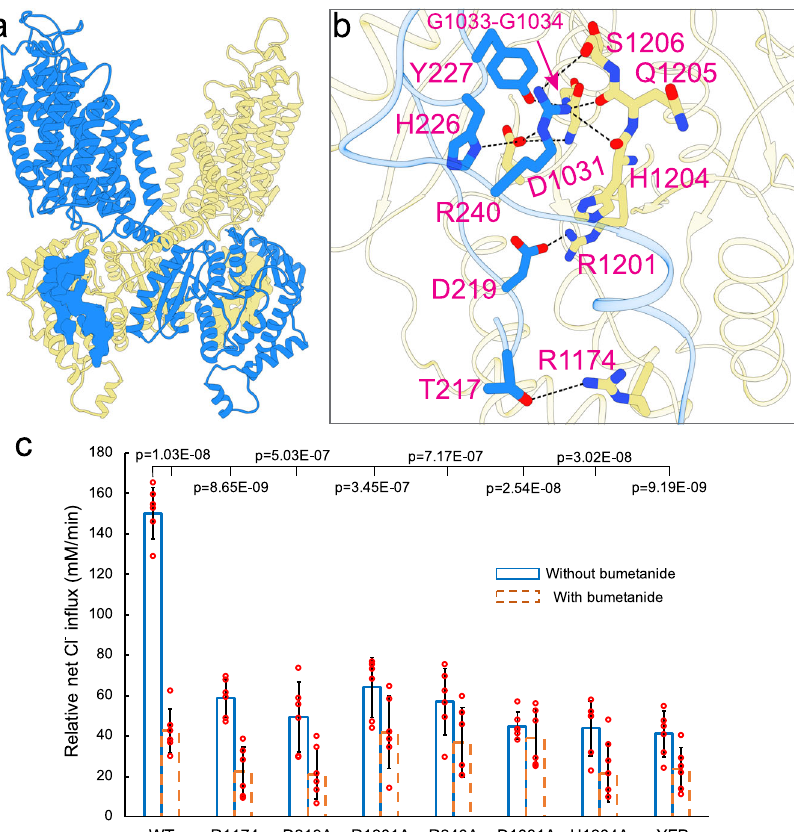
Fig. 2 An N-terminal phosphoregulatory segment associates with the C-terminal domain. a An N-terminal segment shown as density map interacts with a swapped C-terminal domain shown as ribbon. b An enlarged view highlights residues involved in association of the N- and C-terminal domains. Polar contacts are indicated as dashed lines. c Cl − transport rates in insect cells of wildtype NKCC1 and mutants designed to disrupt the N- and C-terminal domain interface. Each circle represents one kinetic measurement of a single sample in a 96 well plate. Unpaired one-tailed Student ’ s t tests are used for statistical analyses ( n = 6; data are presented as mean values ±